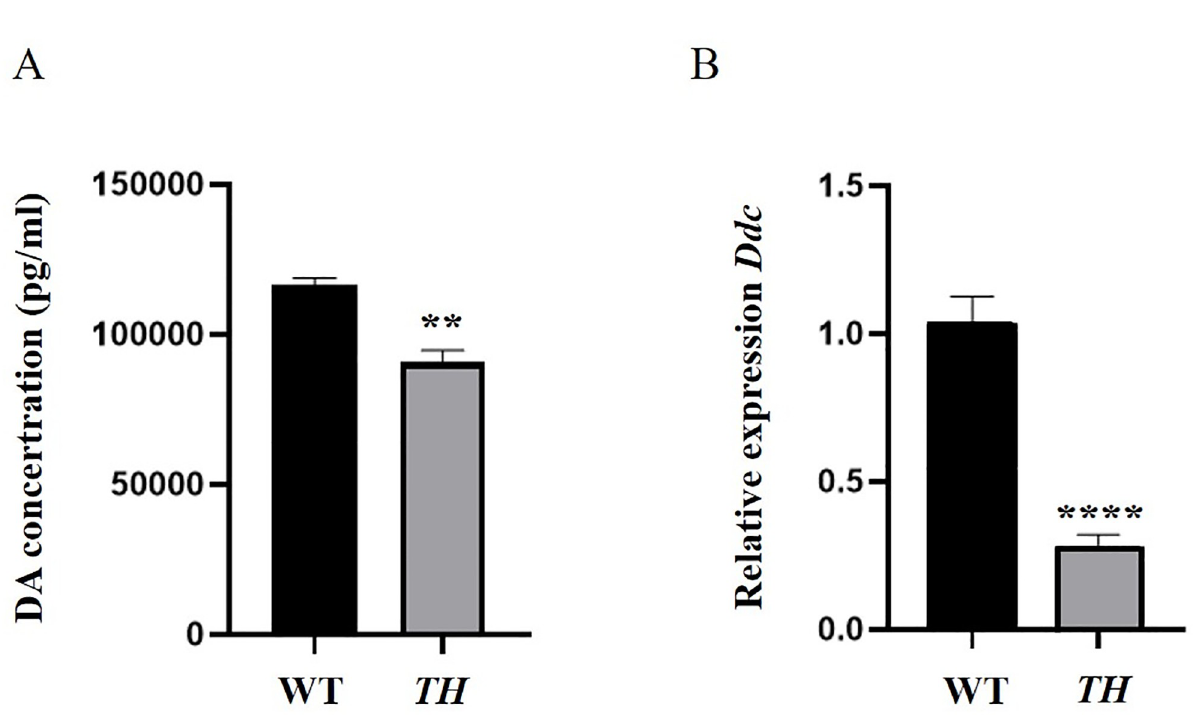
Fig 11. Effects of TH knockout on dopamine concentrations (A) and the expression of cuticle tanning pathway gene: Dopa decarboxylase ( Ddc ) (B) P < 0.0001. ( t = 7.361, df = 22) Three replications are conducted, and the data are presented as mean ± SE. Significant differences between the two treatments are analyzed using a Student’s